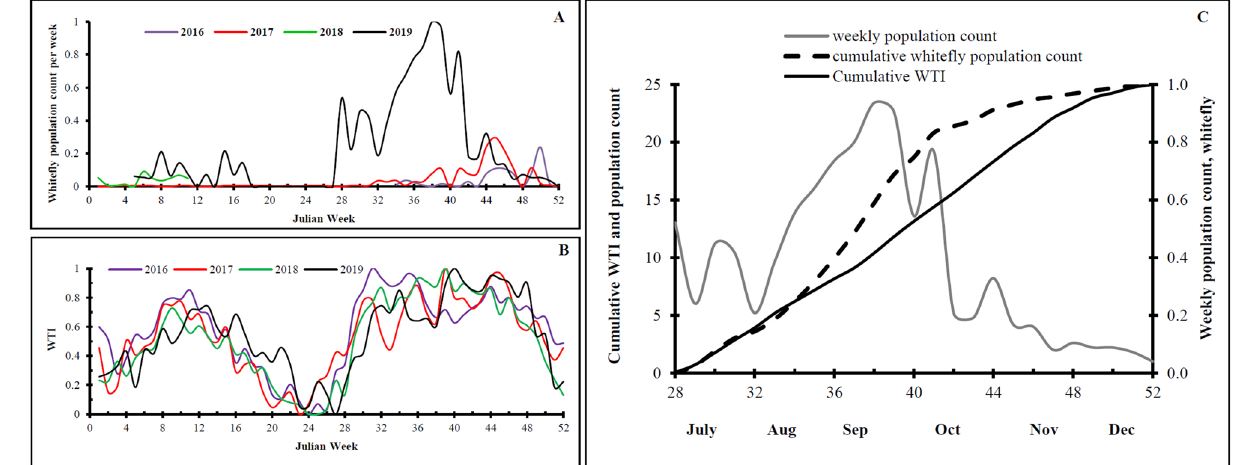
Figure 5. Temperature influence on whitefly population in experimental field IARI New Delhi, A = whitefly population count in Julian weeks; B = weekly temperature index in Julian weeks; and C = cumulative weekly temperature index and whitefly population count.